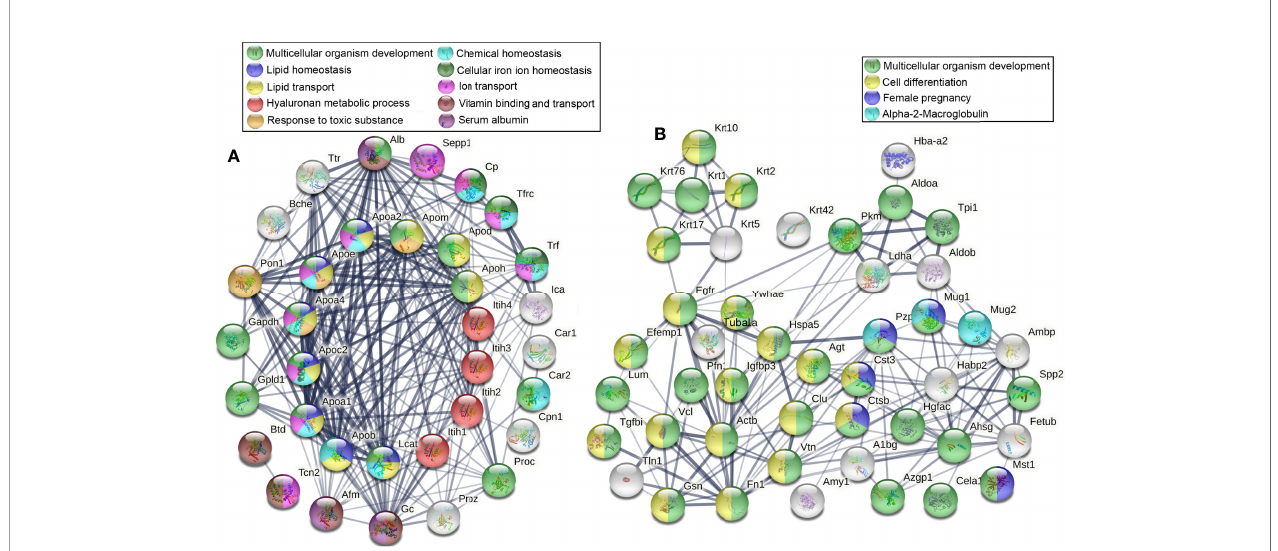
FIGURE 5 | Downregulated DEPs related to homeostasis and multicellular organism development. (A) The DEPs that are related to lipid, ions, and chemical homeostasis accounted for lipid transport, ion transport, vitamin transport, and PH maintenance, their downregulation seriously affected the system multicellular organism development of thyrotoxicosis mice. (B) The DEPs directly related to multicellular organism development, many of them were involved in the cell differentiation process and female